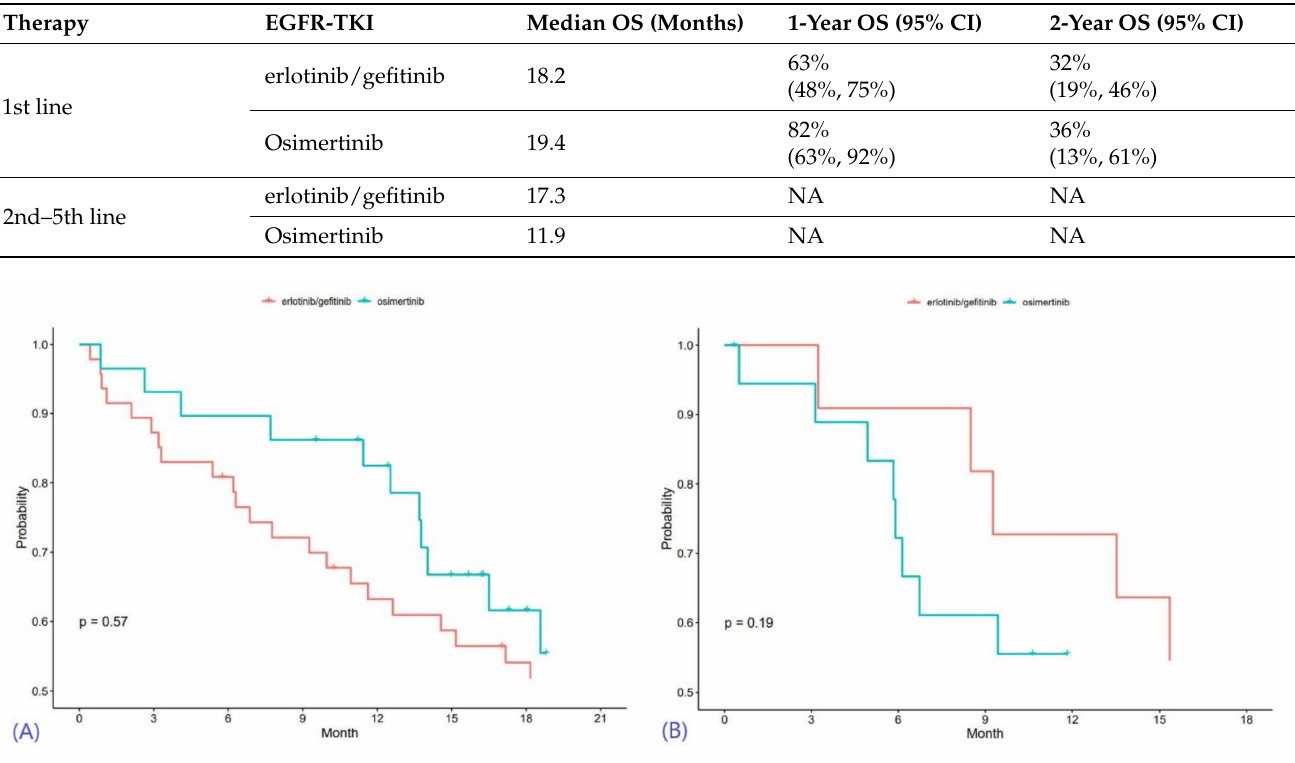
Figure 2. Kaplan-Meier curves for overall survival, with results of first-line therapy in ( A ) and outcomes of later-line therapy in ( B